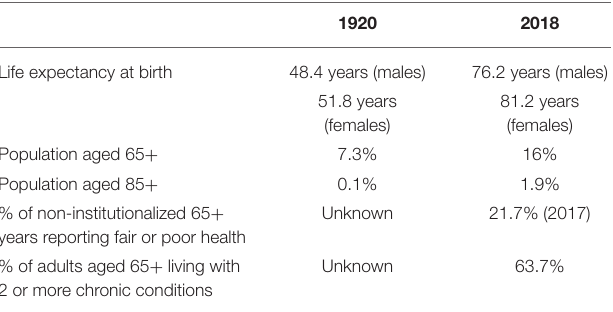
TABLE 1 | The transitions in US demographic and population health status between two